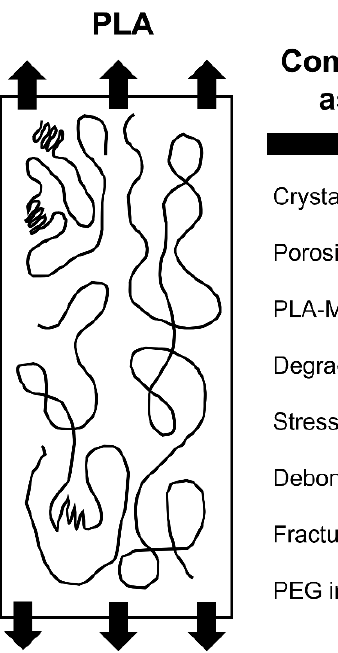
Figure 3. Mechanisms that were considered when determining the tensile strength of the PLA-Mg composites compared with the neat PLA.